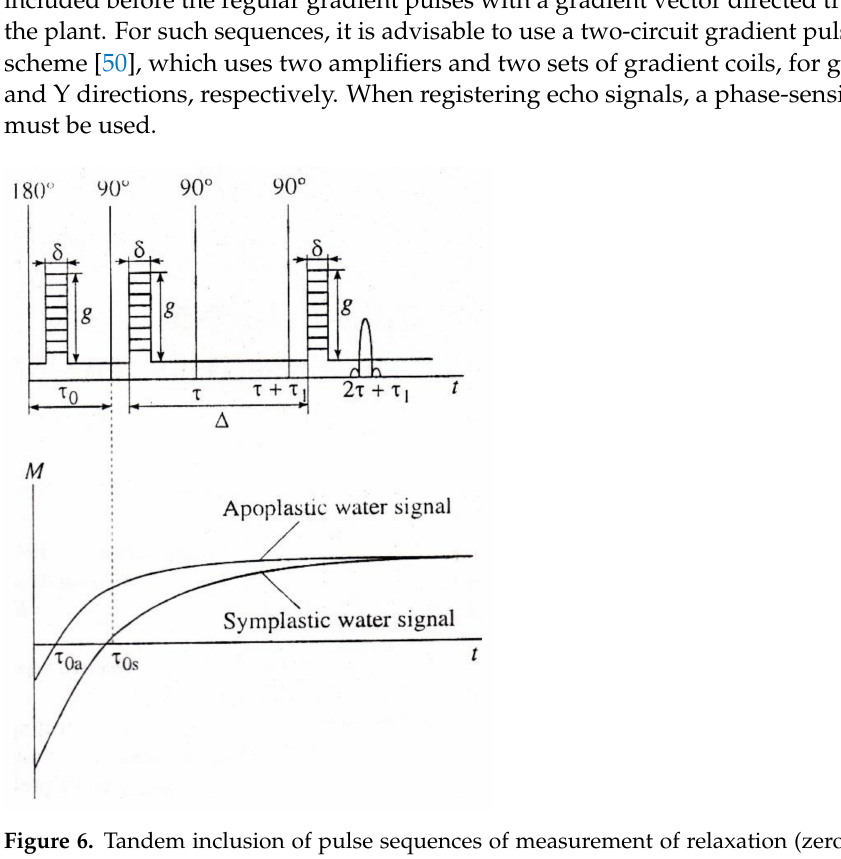
Figure 6. Tandem inclusion of pulse sequences of measurement of relaxation (zero-method) and diffusion (adapted from